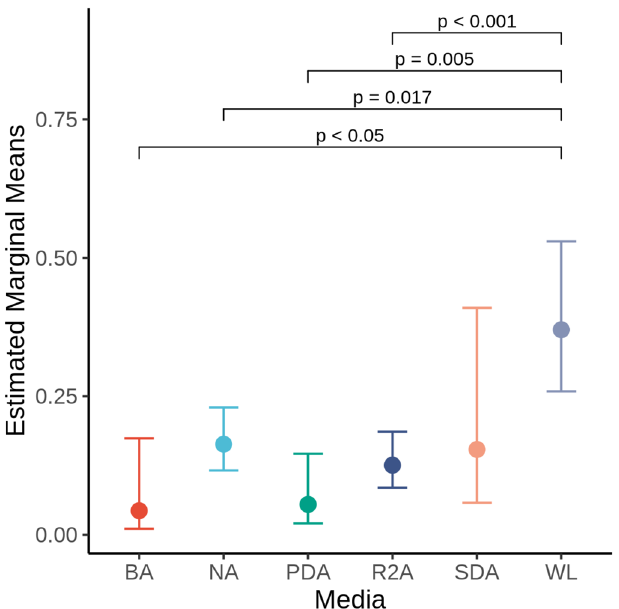
Figure 2. A generalized linear model was used to compare the isolation frequency of Pd -inhibitory bacteria with different types of microbiological media. The estimated marginal means are compared with a pairwise post hoc test, and only the resulting significant differences between groups are shown here with adjusted p values using Sidak correction.